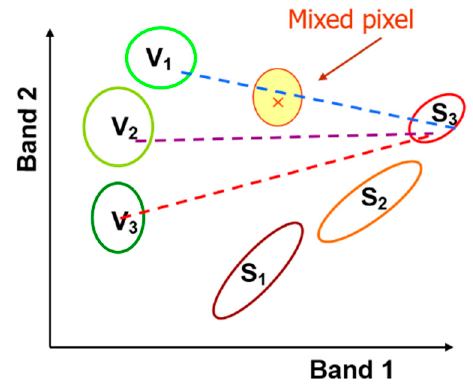
Figure 3. Illustration of the model selection in a bidimensional feature space. Dashed lines join random spectra drawn from soil class S 3 and vegetation classes V 1 , V 2 and V 3 .